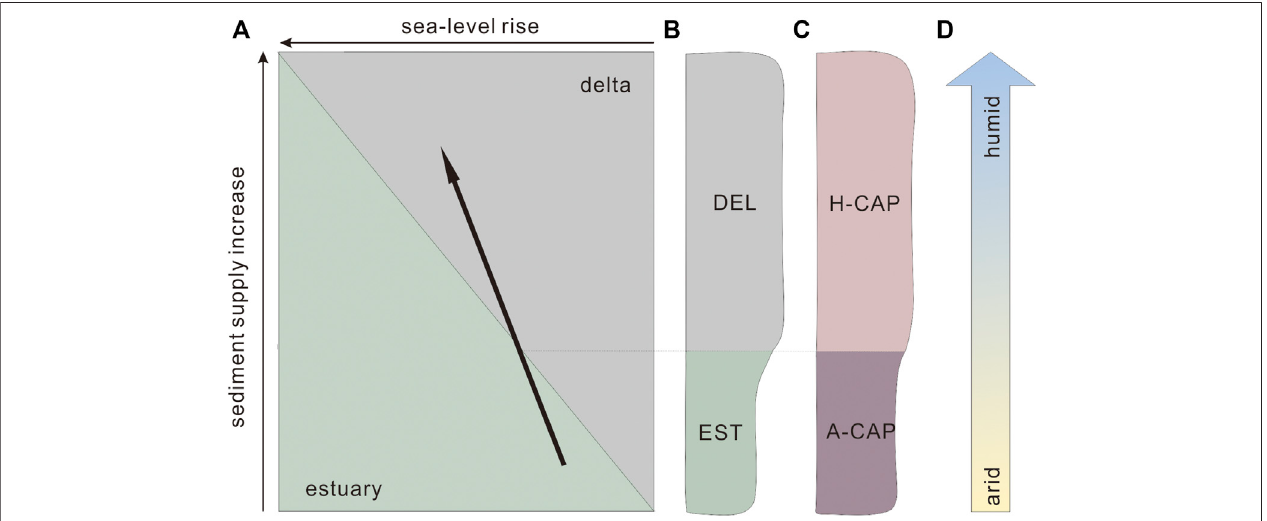
FIGURE 8 | Evolution and interpretation of the estuarine to deltaic facies transition in the lower Liangshan Formation. (A) Estuary to delta evolution model revised from Boyd et al. (1992), and the black arrow indicates the inferred estuarine to deltaic facies transition in the lower Liangshan Formation. (B) Sedimentary facies architecture of the lower Liangshan Formation based on the Caohai, Houpo, and Mapojiao successions. (C) Sedimentary facies architecture of the lower Liangshan Formation based on the Xiuhe succession. (D) Assumed relatively arid-to-humid climate shift recorded in the lower Liangshan Formation of the Xiuhe section.